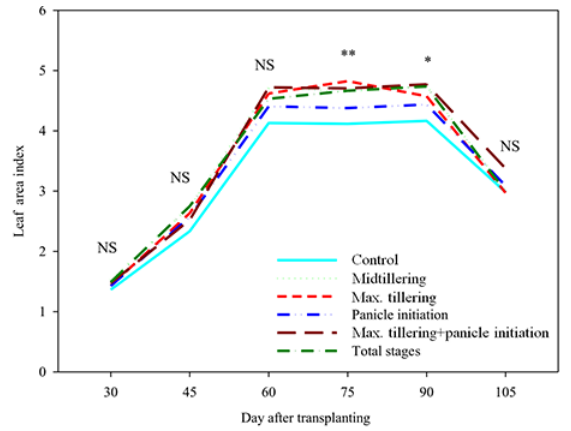
Figure 5 Effect of the foliar application of nutrients on the leaf area index in different growth stages. NS, *, and ** mean not significant and significant at 5% and 1% probability level, respectively.